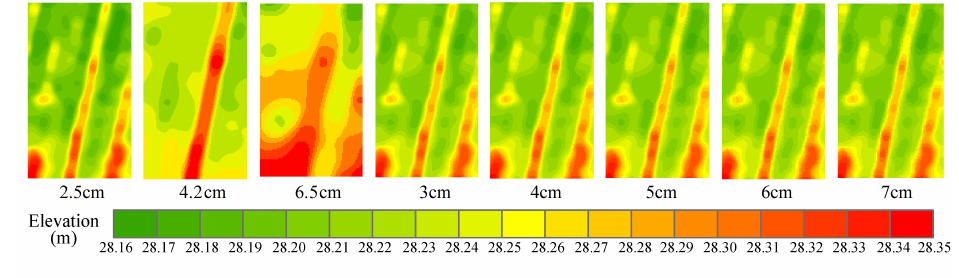
Figure 16. The impacts on mapping performance of different resolution images: ( a ) recall and AEA, ( b ) length ratio error, ( c ) area ratio error; typical images of cropland ridge: ( d ) orthophoto and ( e ) DSM in different GSD with the actual extent: 2.1 m × 3.5